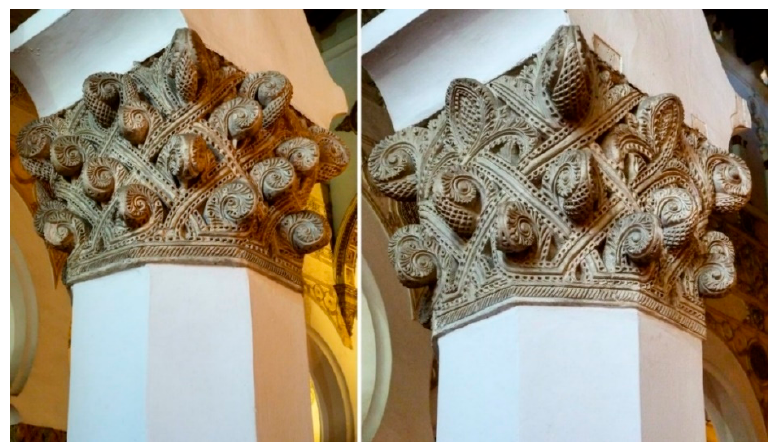
Figure 6. Two capitals of the Synagogue of Santa María la Blanca of Toledo. Author’s photo.